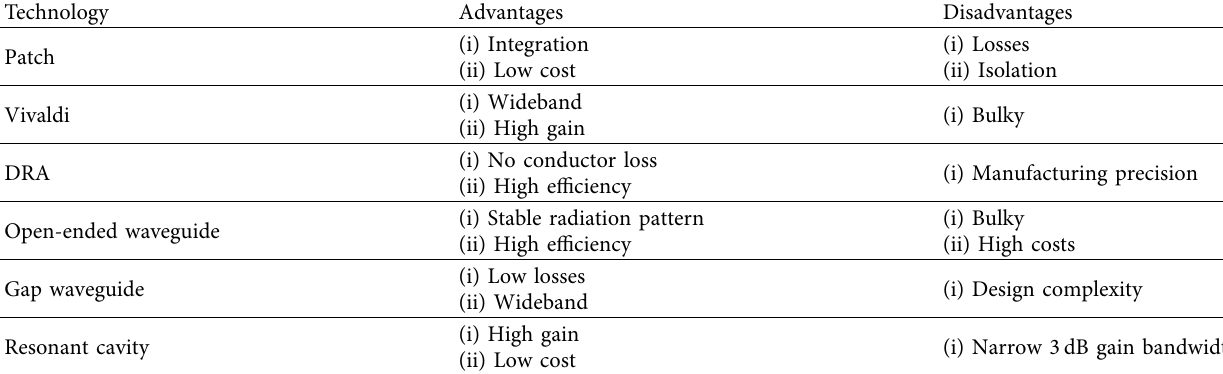
Table 1: Advantages and disadvantages of commonly used antenna technologies for array development. Technology